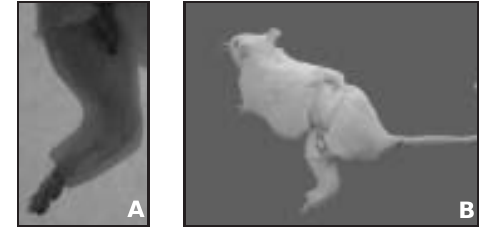
Table 1. Effect of immobilization on muscle glycogen concentration, soleus fiber and connective tissue area of rat submitted to joint immobilization for 7 days.